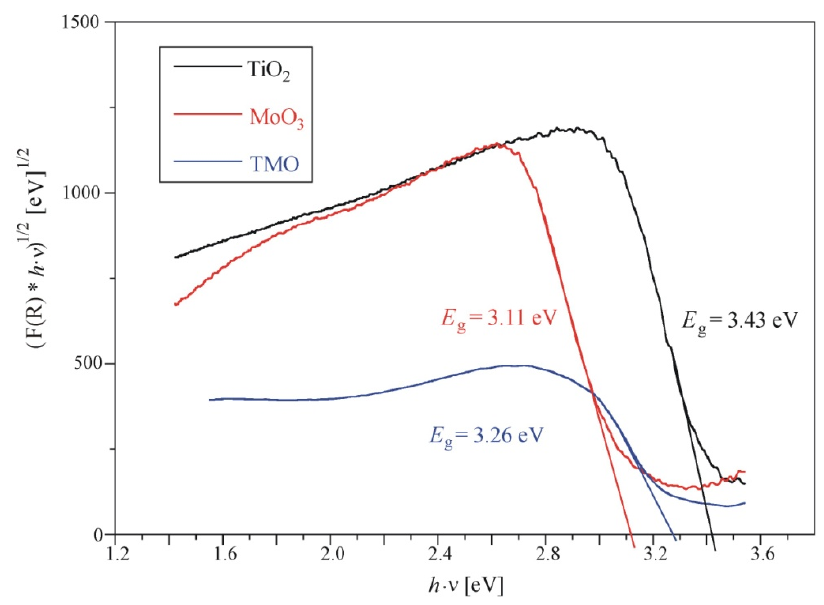
Figure 5. The ( F ( R ) · h ν ) 1/2 vs. photon energy (h ν ) plot of anatase TiO 2 ( black solid line ), MoO 3 ( red solid line ), and TMO ( blue solid line ).